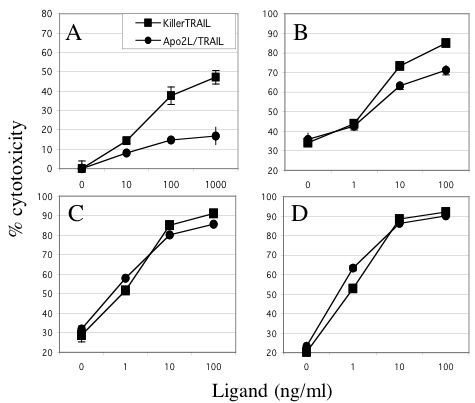
Cytotoxic effects of KillerTRAIL and Apo2L/TRAIL in vitro. PC3 cells were incubated with ligand at the indicated concentrations without (A), or with 0.25 μg/ml (B), 0.5 μg/ml (C) or 1 μg/ml (D) doxorubicin for 24 hours. Data shown are the mean ± SEM from a representative experiment. Similar results have been obtained three times.